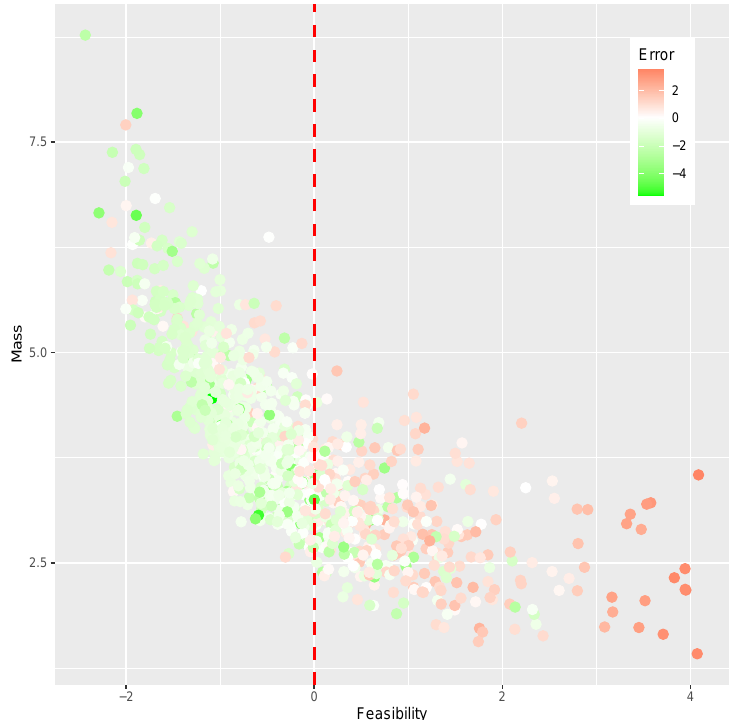
Figure 17. Feasibility error level log ( | ∆ 2 | ) at several mass and feasibility